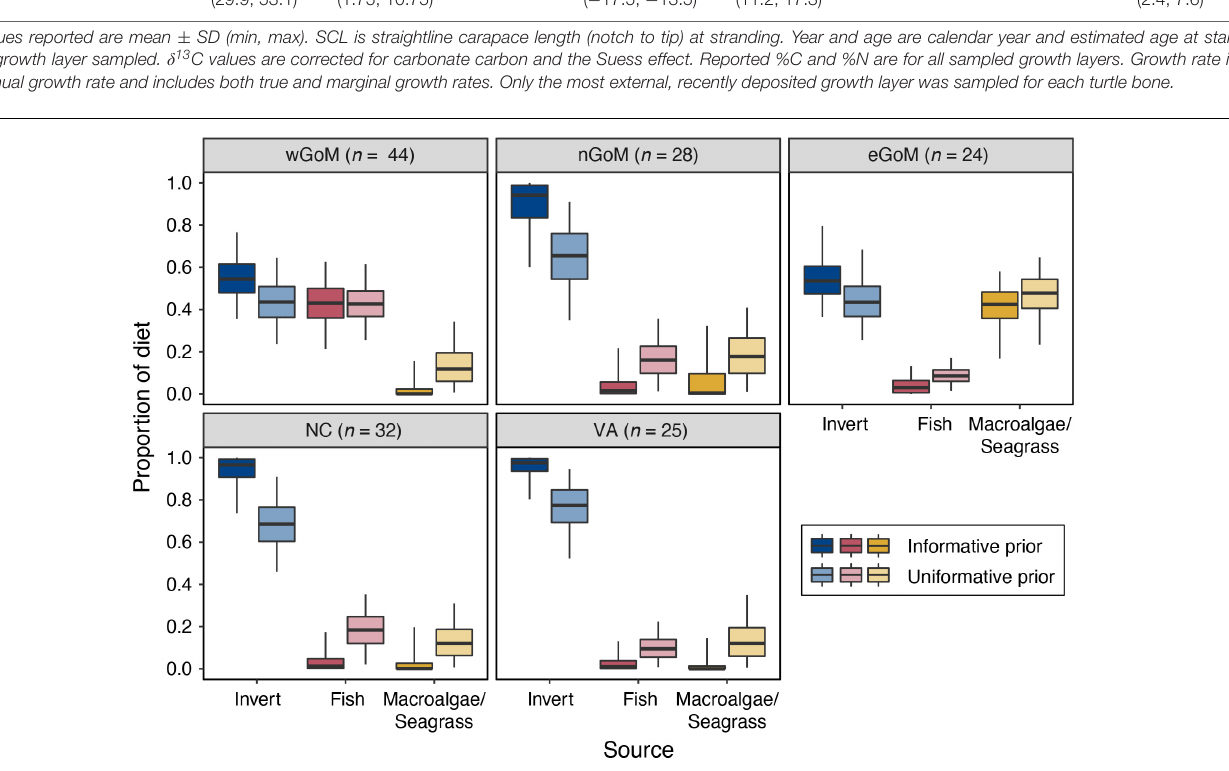
FIGURE 3 | Proportional contribution of each prey group to Kemp’s ridley sea turtle diets by geographic region based on MixSIAR models that included an informative prior constructed from published diet proportion data and an uninformative prior that assigned equal probability to all prey groups. Turtle sample sizes are presented at the top of each plot. Data for invertebrate prey groups (crustacean, bivalve, and gastropod) were aggregated a posteriori . Lines in boxes are medians, boxes are 50% credible intervals, error bars are 95% credible intervals. See Table 4 for samples sizes, medians, and credible interval